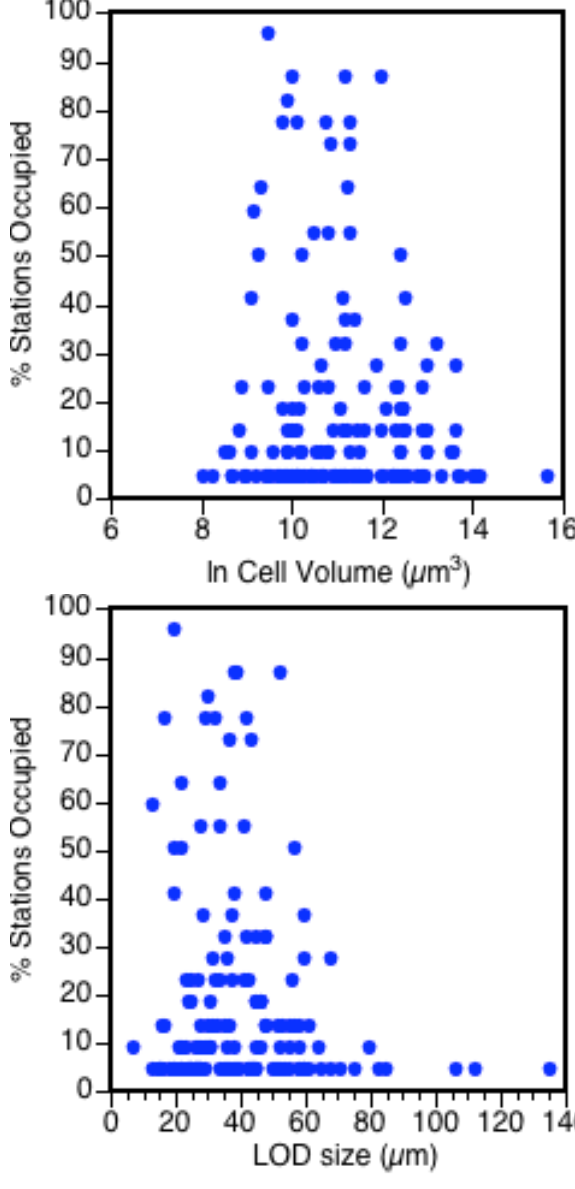
Fig. 7. Scatter plots of occurrence rates of tintinnid species, as a % of stations occupied, among the stations and morphological characteristics. The top panel shows the lack of relationship of occurrence rate and lorica volume (Rho value = -0.003, p = 0.97) and the bottom panel shows a similar lack of relation with LOD size (Rho value = -0.028, p = 0.73). Thus, neither lorica volume nor oral diameter appear linked to average occurrence.